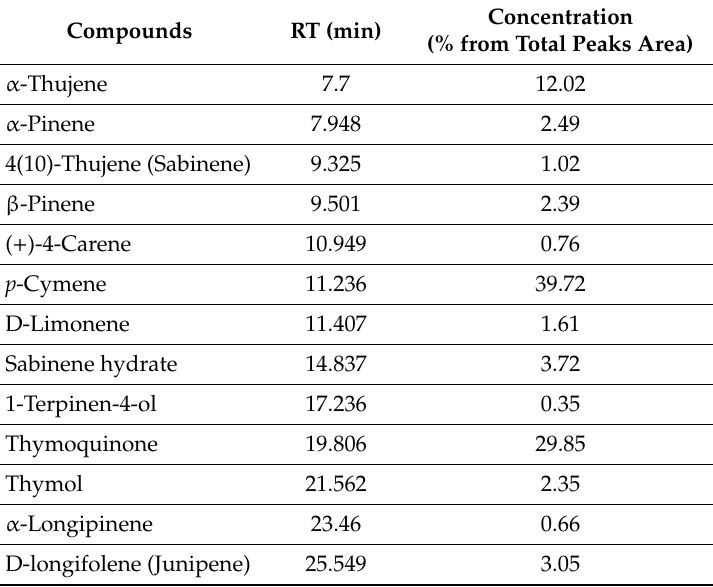
Table 3. Gas chromatography coupled with mass spectroscopy (GS-MS) chemical composition of volatile compounds identified in